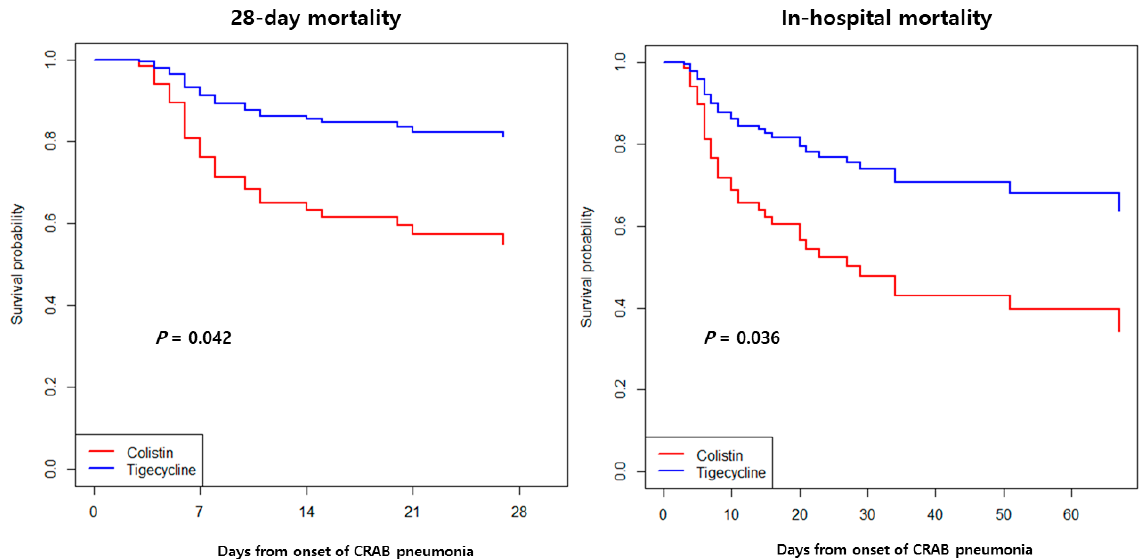
Figure 2. Kaplan–Meier survival curves for the multivariate model comparing the meropenem–colistin and meropenem– tigecycline groups in patients with carbapenem-resistant Acinetobacter baumannii (CRAB) pneumonia.